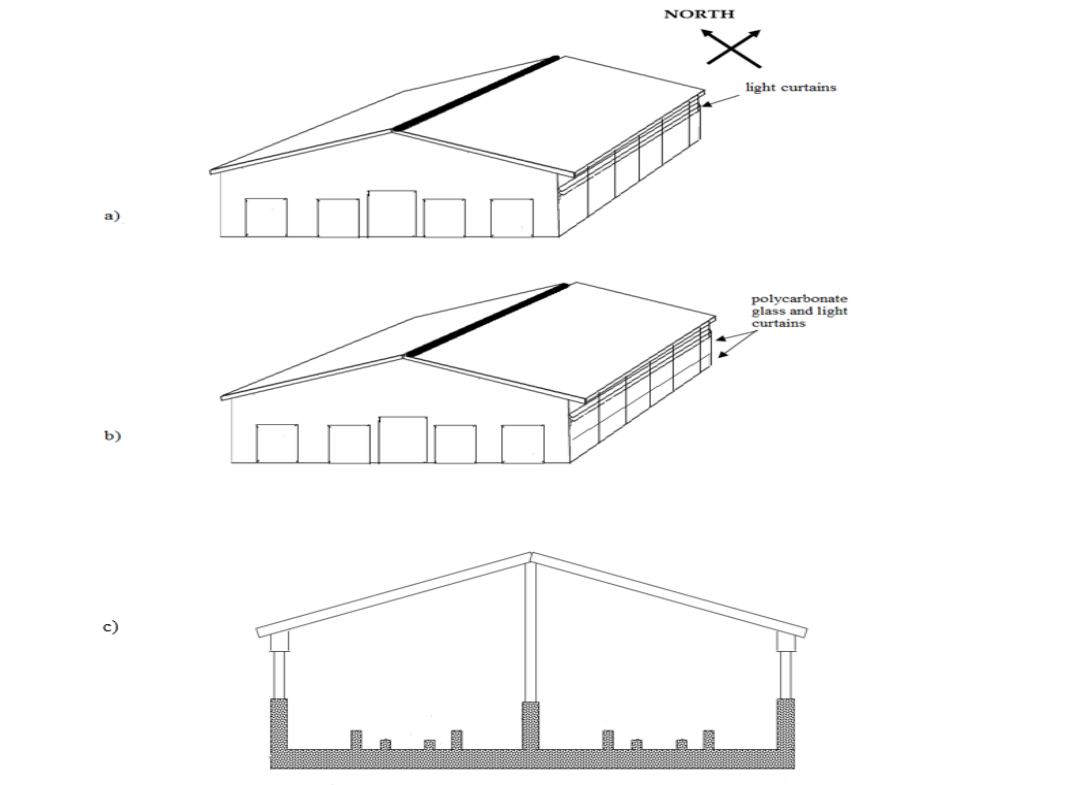
Fig 1. Type of easily assembled premises: a) without insulation elements; b) with elements of warming; c) premises with